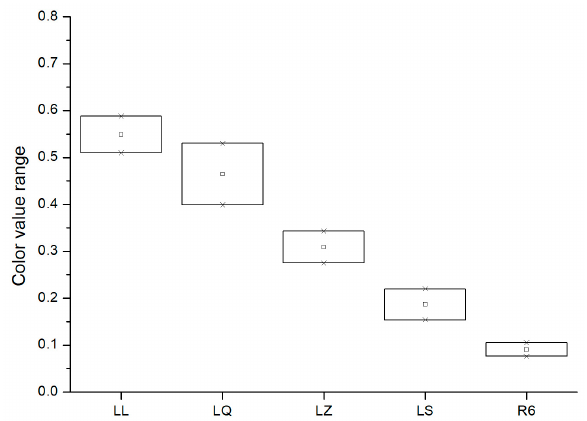
Figure 9. The five color categories intervals of the cells in the existing laser detection system.